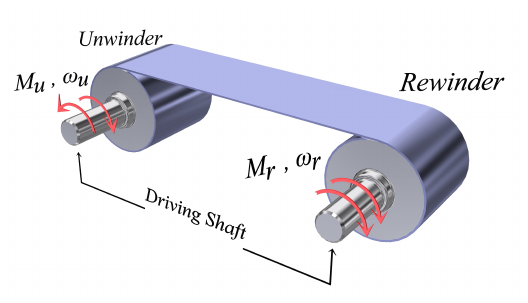
Figure 1. Model of single-span roll-to-roll web